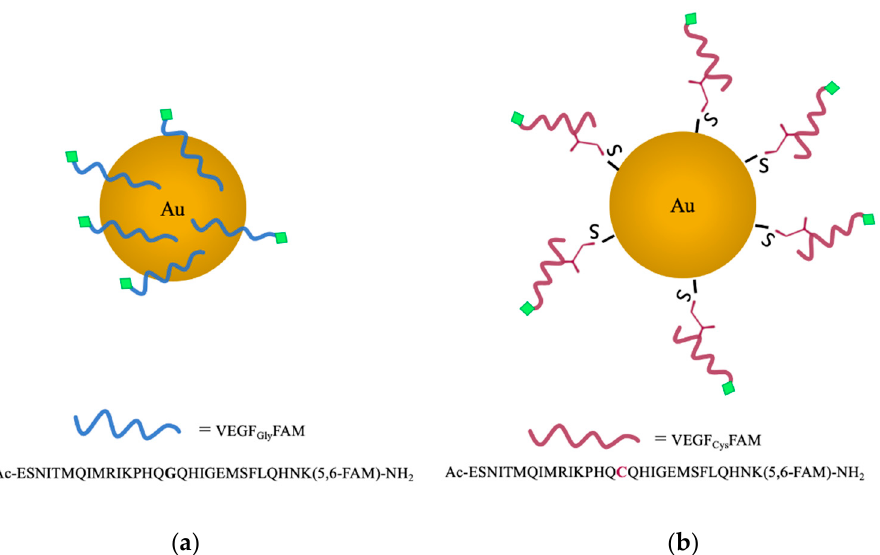
Scheme 1. A pictorial representation of AuNPs functionalized with VEGF Gly FAM ( a ) and VEGF Cys FAM ( b